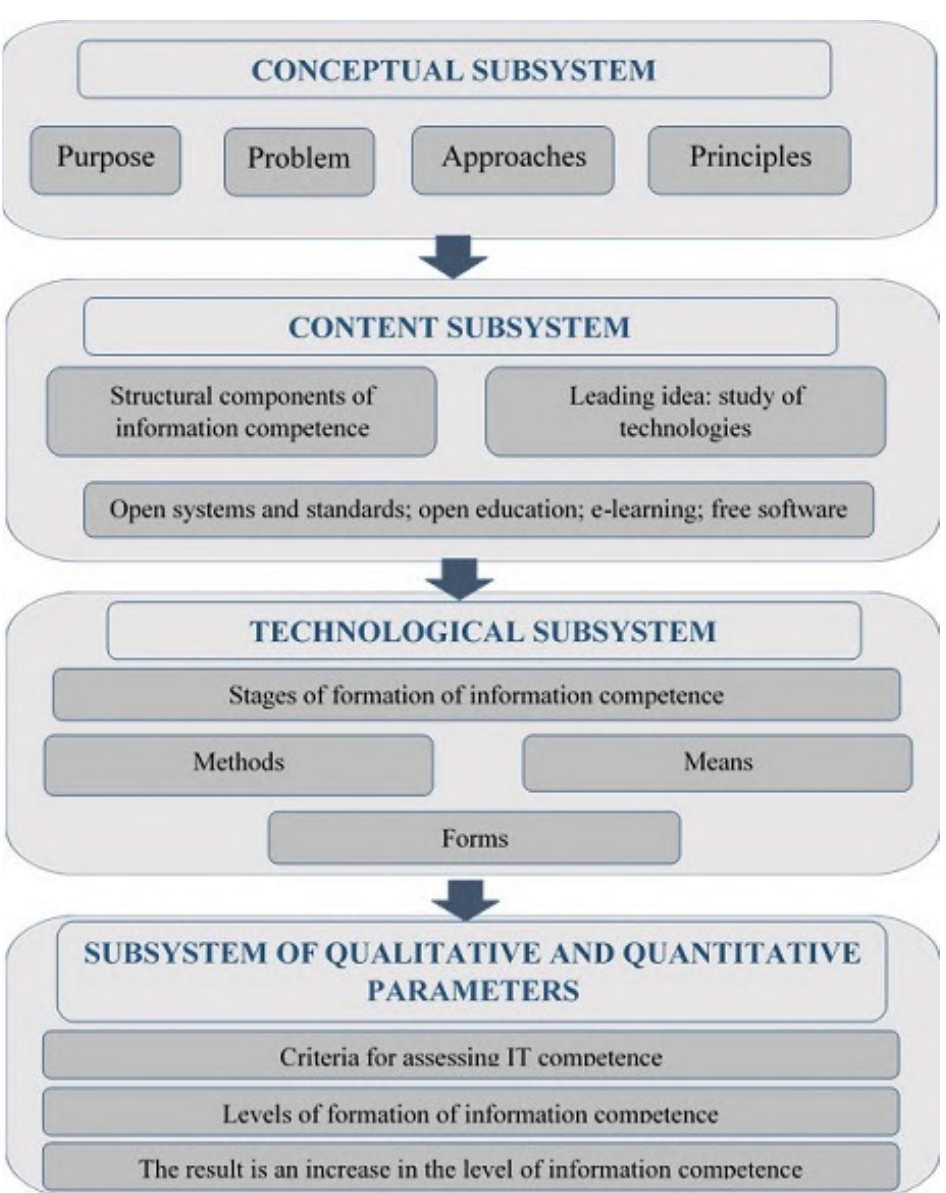
Figure 74: Presentation of paper